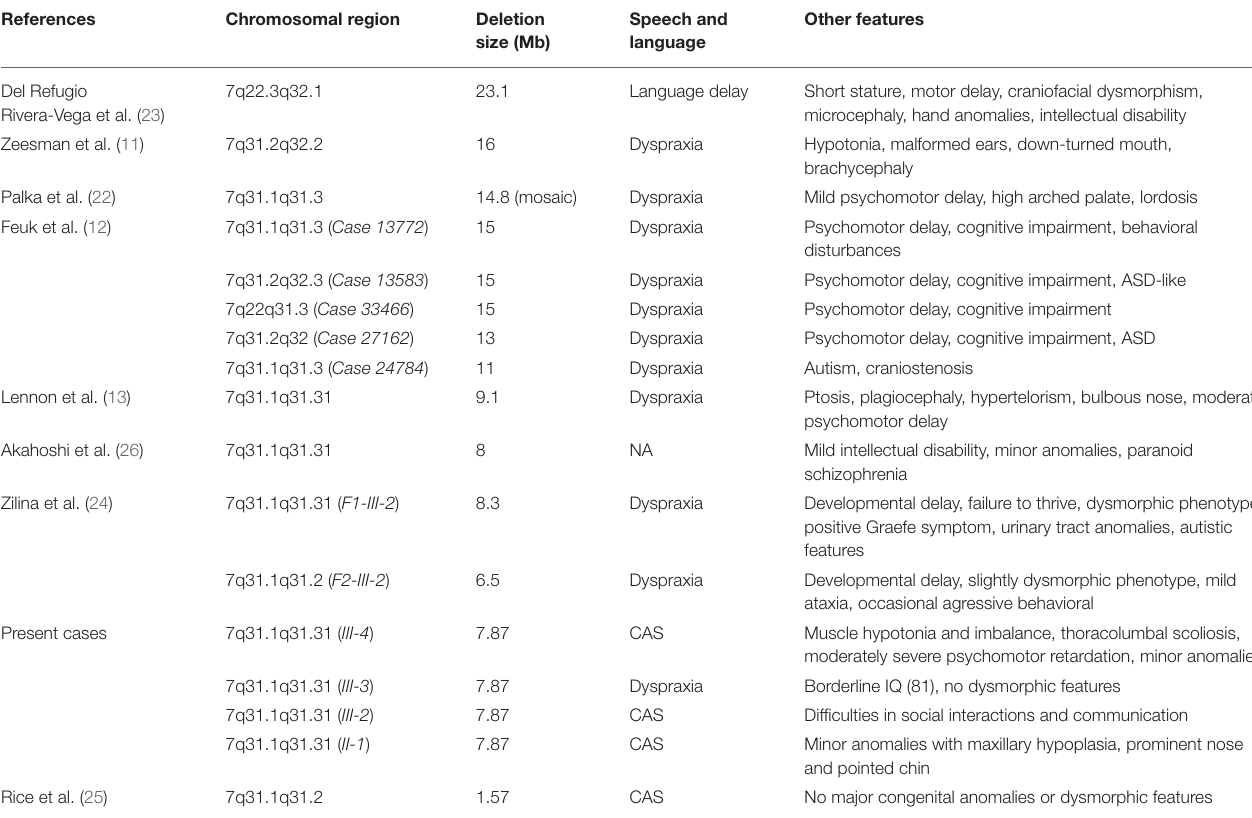
TABLE 2 | Cytogenetic, molecular, and clinical data of patients with 7q deletion encompassing the FOXP2